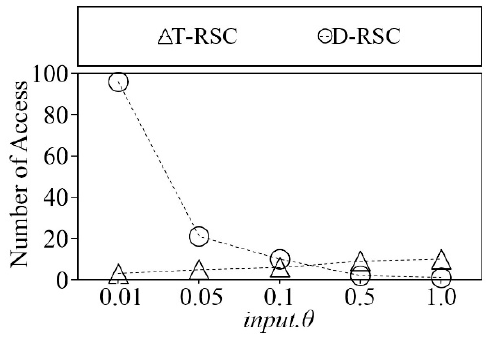
Figure 16. Comparison of number of cluster accesses on synthetic dataset.